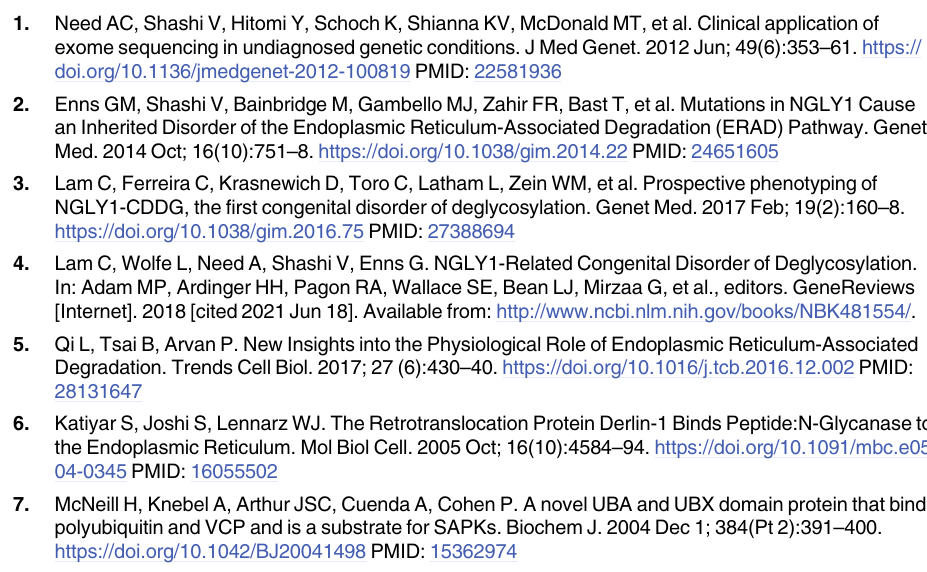
S4 Table. Input and results for the CMAP analyses. S5 Table. Fly counts from the GSK3/sgg inhibitor and sgg-RNAi